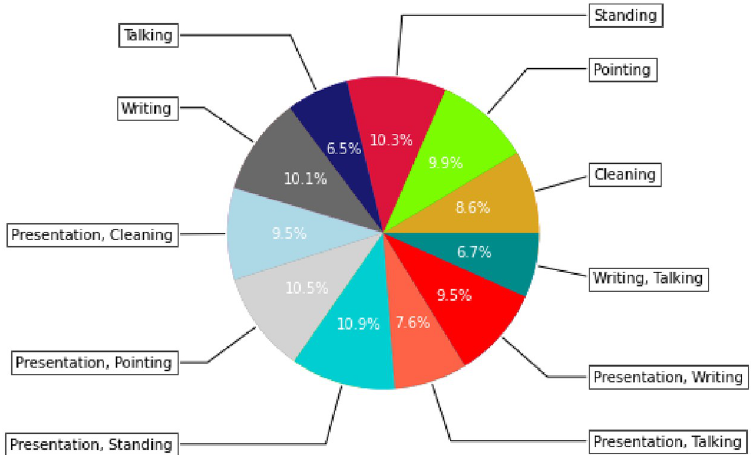
Fig 6. The graph in this image depicts a distribution of classes in training data in a LOOCV